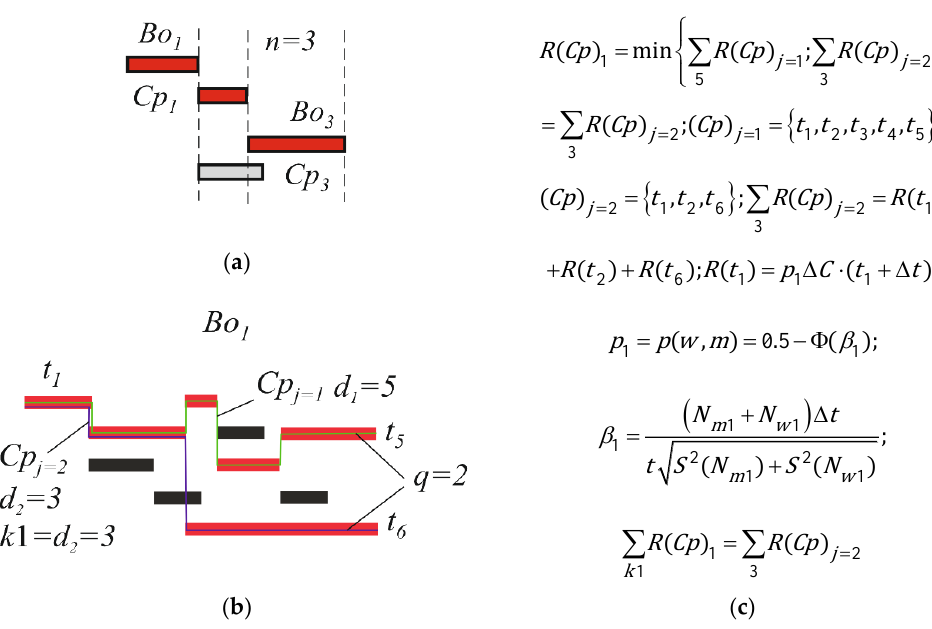
Figure 3. A case of variables taken from Equation (6) used to simulate three facilities ( a ), if the schedule of the first facility has two critical paths ( b ), results of using Formula (7) for the schedule in ( c ).